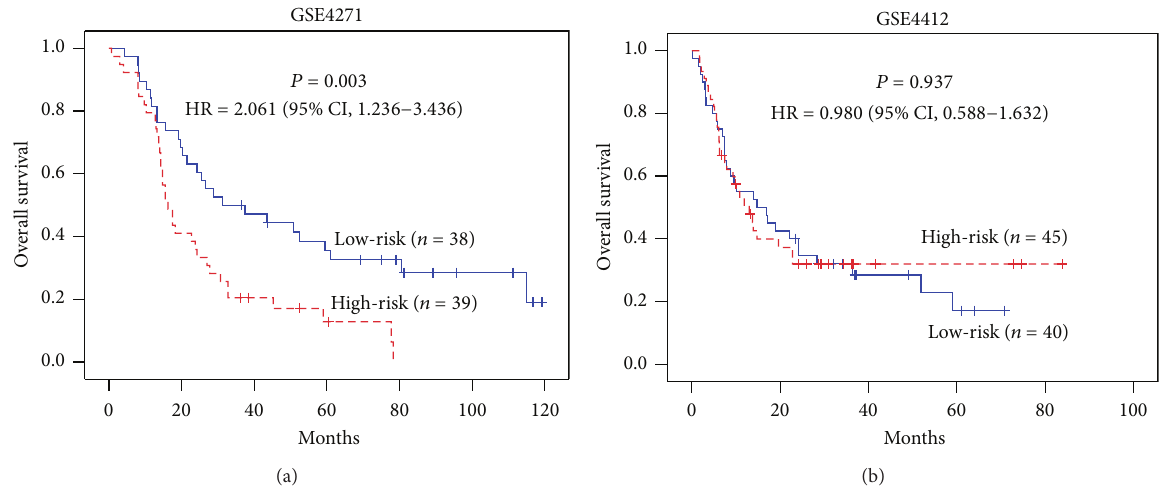
Figure 5: Survival analysis of the glioma patients using ten hub genes reported by Eschrich et al. Abbreviations: HR—hazard ratio; CI— confidence interval. The Cox regression model was trained by ten hub genes. The median of the estimated risk scores was used as the cutoff to divide the patients into high-risk and low-risk groups. 𝑃 values were obtained from the log-rank